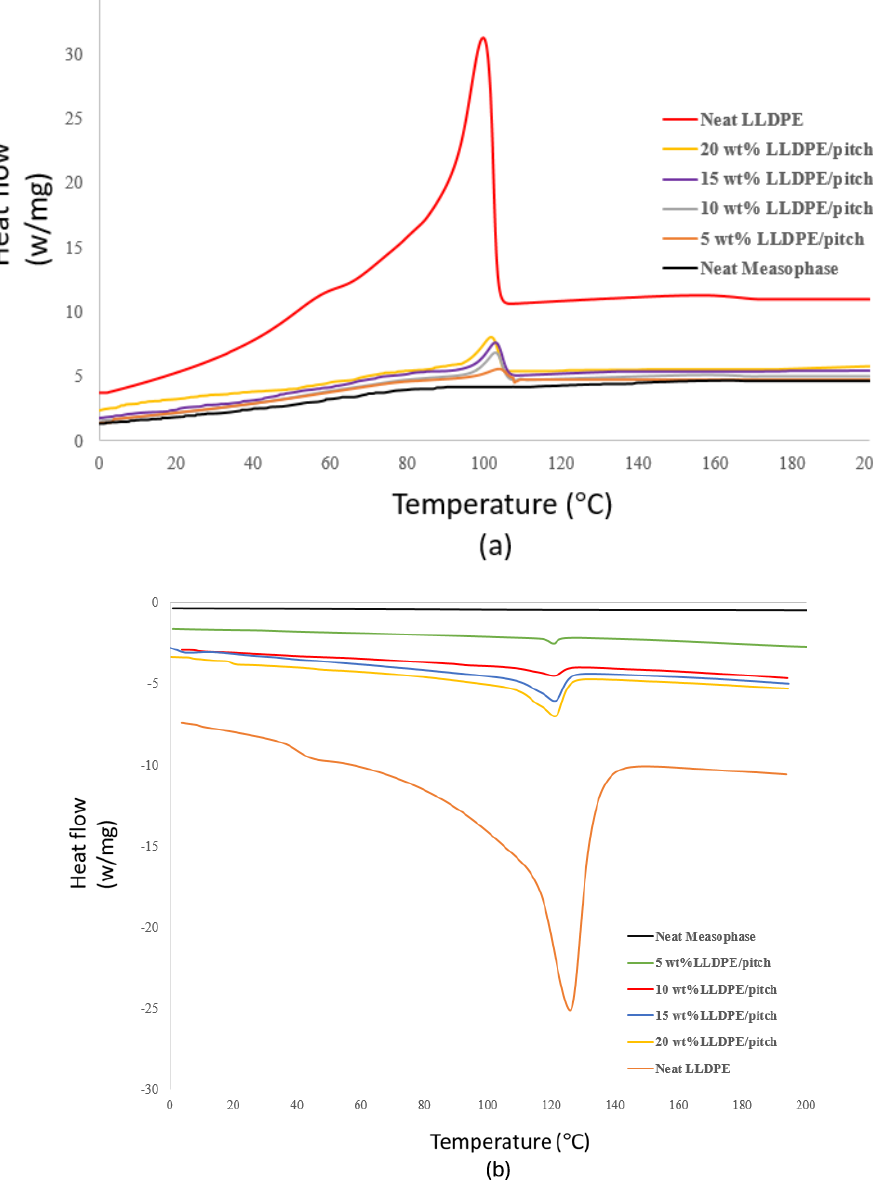
Figure 6. ( a ) Crystallisation, and ( b ) melting behaviour of LLDPE and LLDPE/mesophase pitch blend.